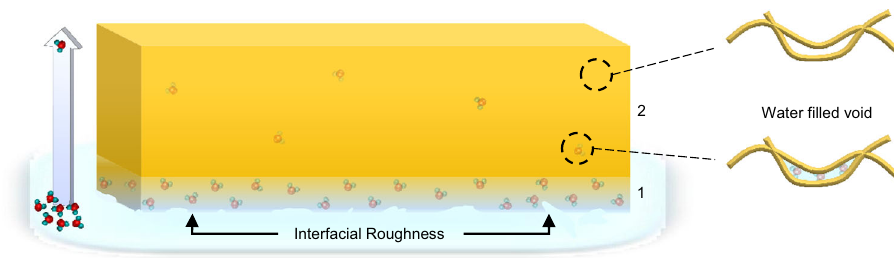
Fig. 6 Illustration of water residing within a representative hydrophobic fi lm, with the majority of water present at the relatively rough polymer – water interface. Layer 1 depicts decreasing water content with increasing distance from the fi lm – water interface followed by a reduced water content in layer 2. “ Wet ” and “ dry ” polymer chains are depicted on the right, illustrating that the water resides within pre-existing voids throughout the fi lm and does